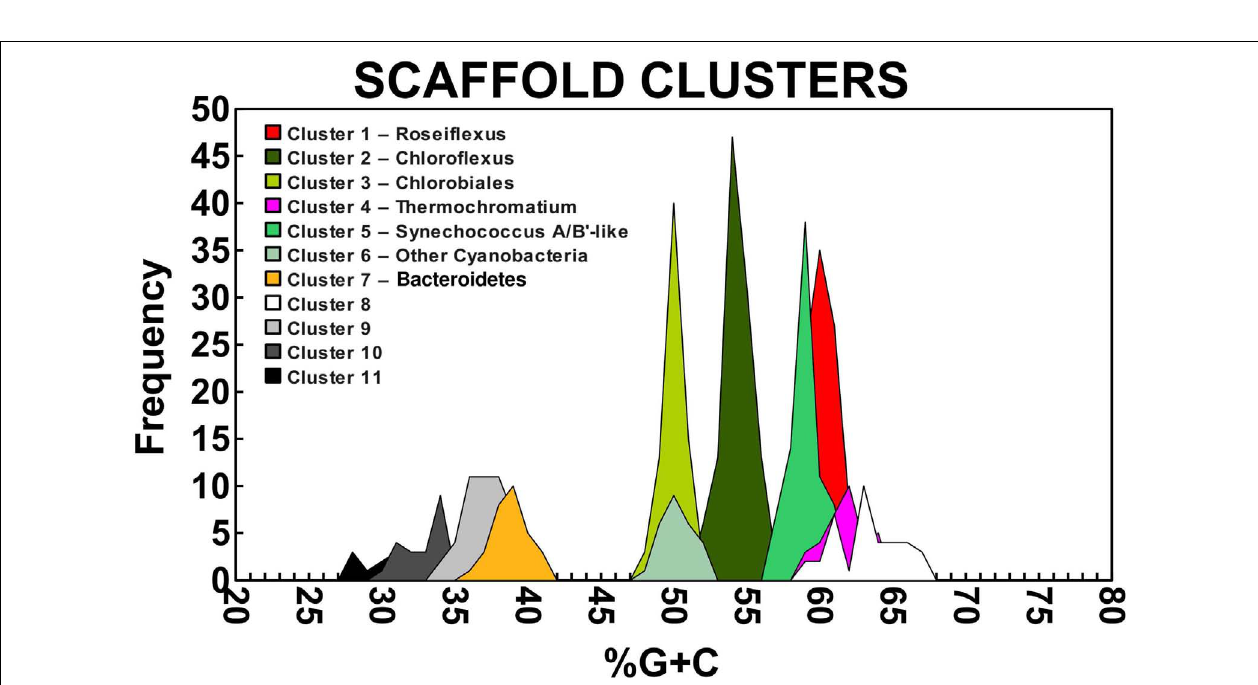
FIGUREA5 | G + C Composition of Scaffold Clusters . Scaffold clusters greater than 10kbp were demarcated using oligonucleotide frequencies as depicted in Figure 4 .